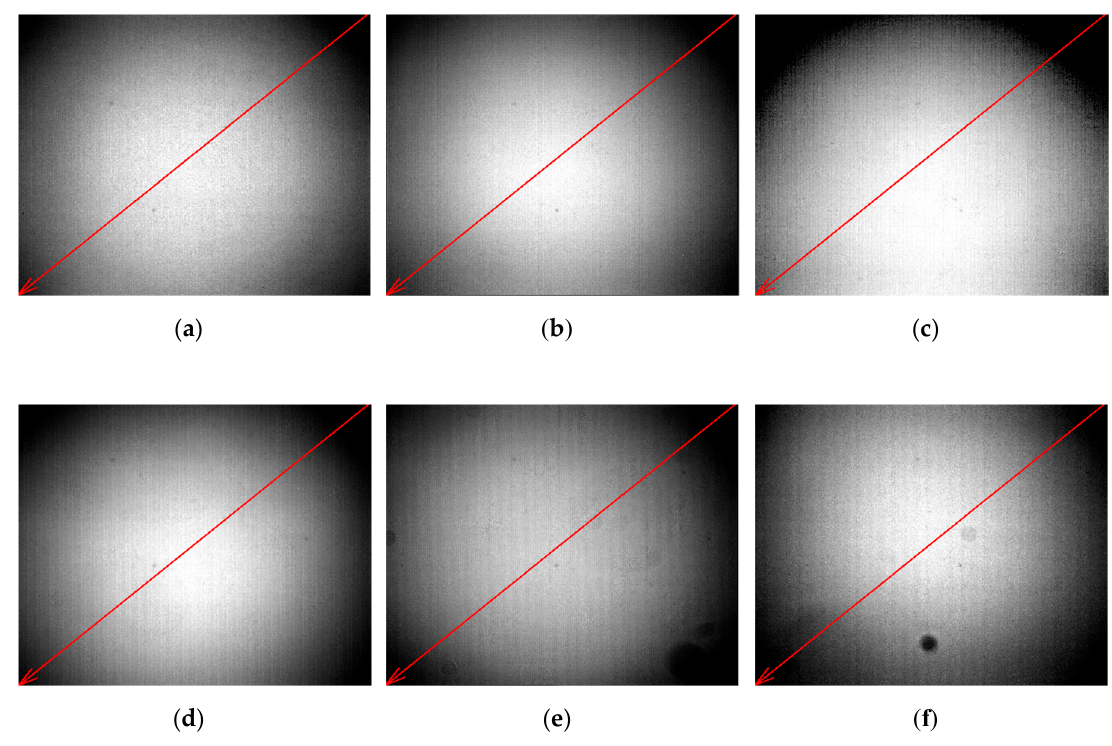
Figure 14. The vignette effect of μ MCA camera channels: ( a ) Band 5; ( b ) Band 6; ( c ) Band 1; ( d ) Band 2; ( e ) Band 3; ( f ) Band 4 (Master). The order of channels is in consistent with physical location of sensors on the camera. The red arrow marks a vignetting profile where correction coefficients were subjected to further investigation for each. Profile starts in upper right corner and ends in lower left corner.